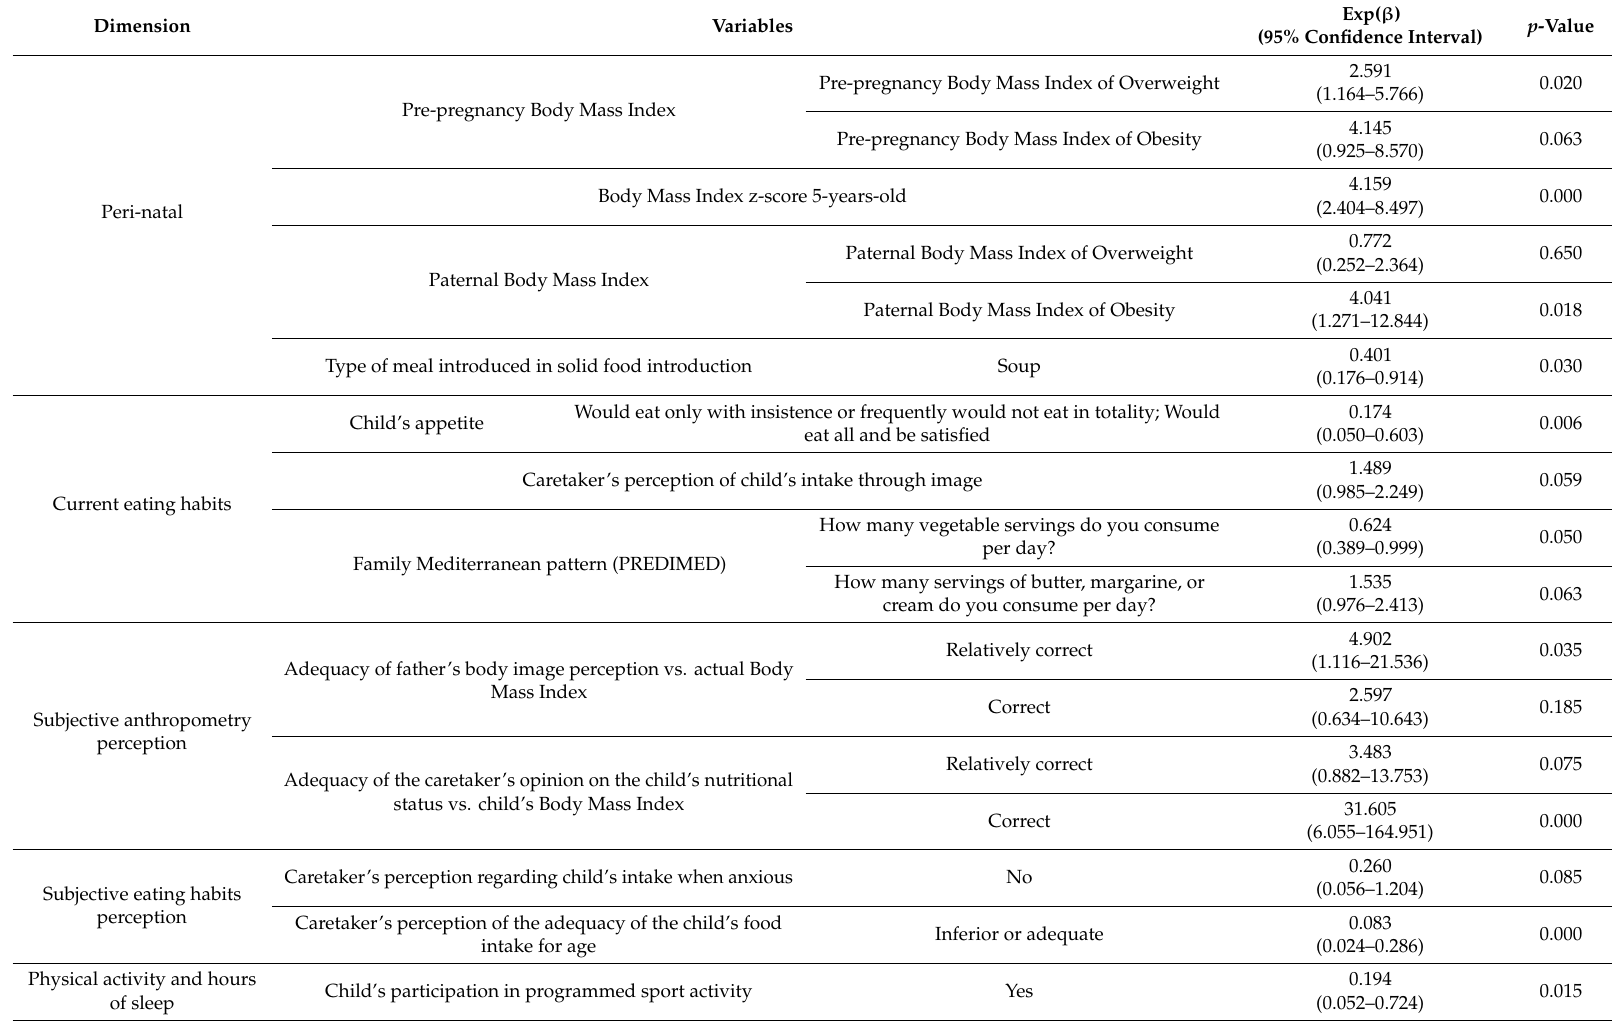
Table 3. Variables retained in the statistical